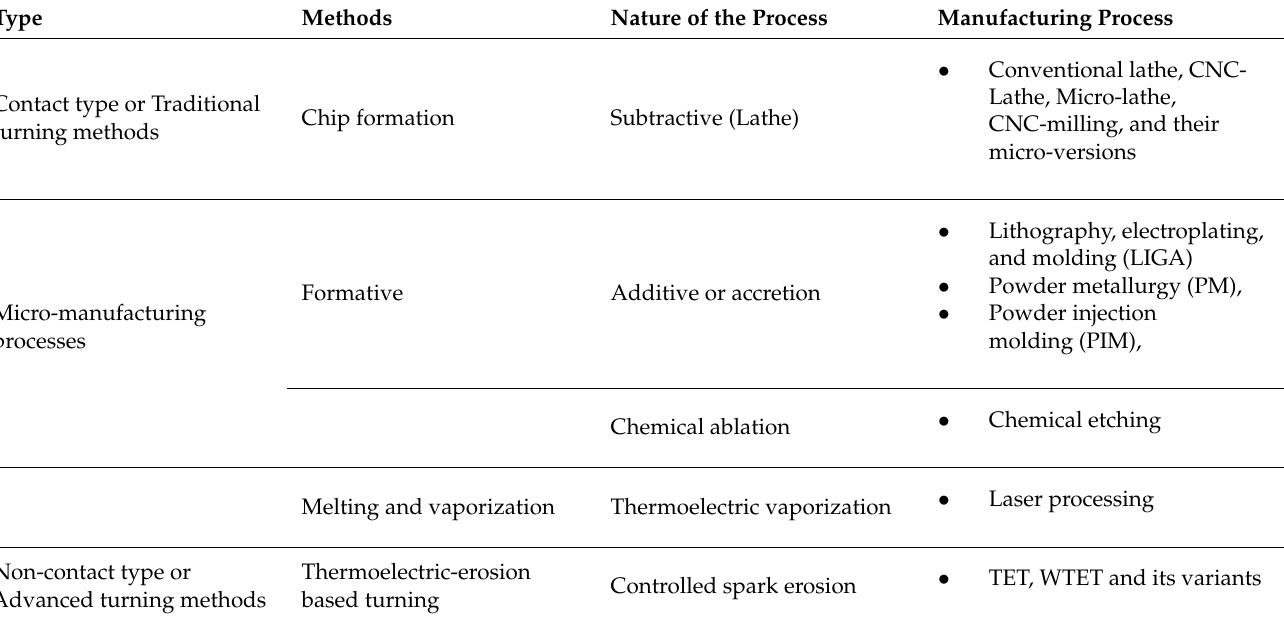
Table 2. Commonly used turning methods to fabricate different types of cylindrical